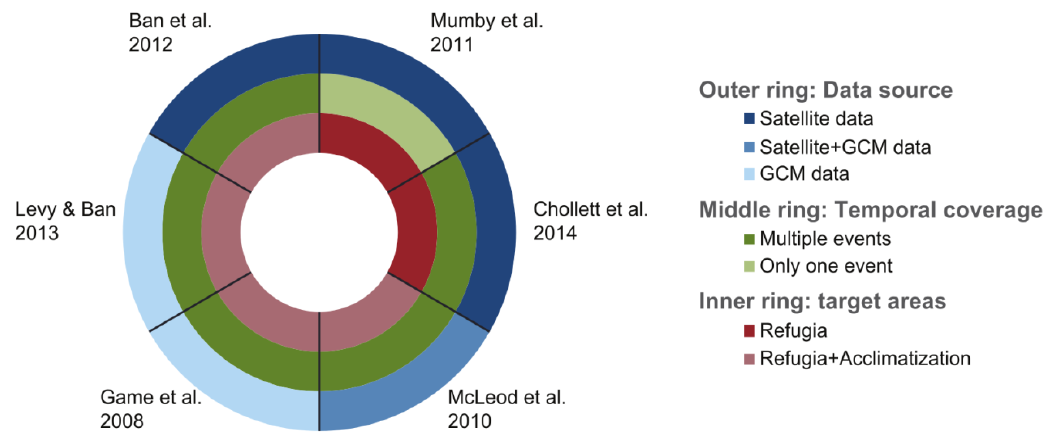
Figure 9. Comparison of methods available to prioritise areas for conservation in a climate change context. Contrasts in terms of the source of the data used (blue ring), the temporal coverage of the analyses (green ring) and the type of areas targeted for protection (red ring) (source [299], references cited clockwise starting at Mumby et al. , 2011 are [2986–300]).